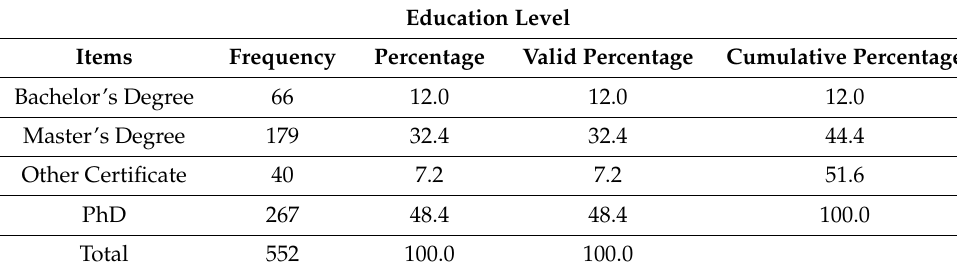
Table 3. Demographic information of the respondents by education level.